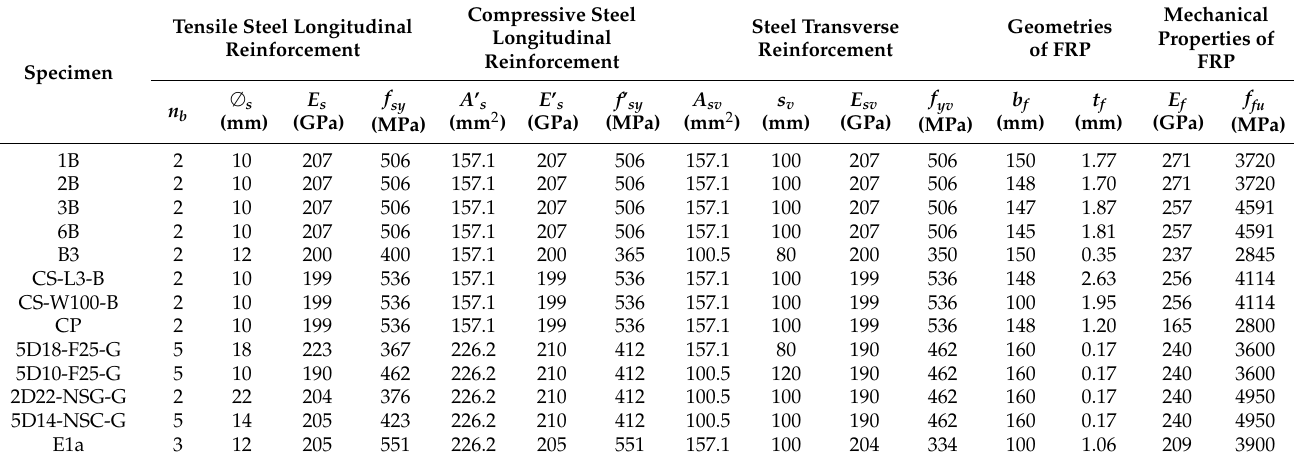
Table 2. Mechanical and geometrical properties of steel reinforcement and FRP